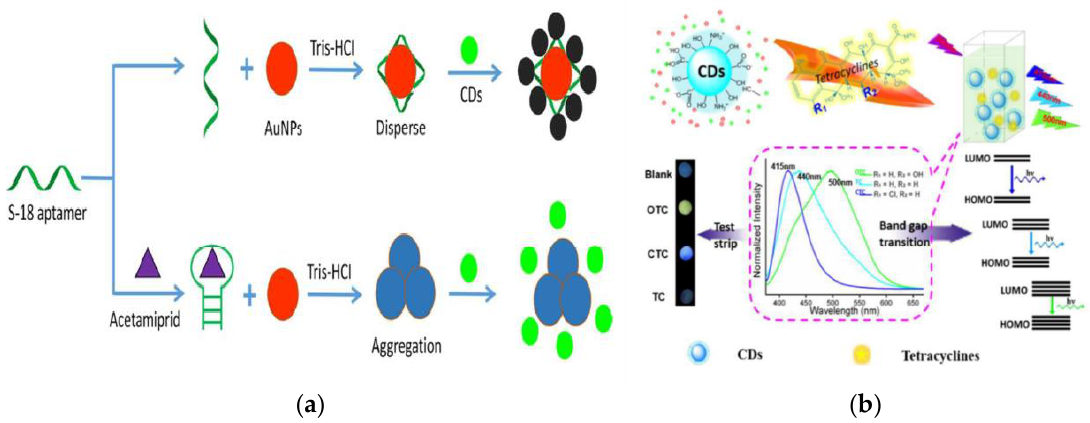
Figure 7. ( a ) Schematic of the fluorescent aptasensor for acetamiprid detection based on AuNPs and CQDs. Reproduced with permission from [121]. Copyright Analyst, 2018; ( b ) Schematic of three